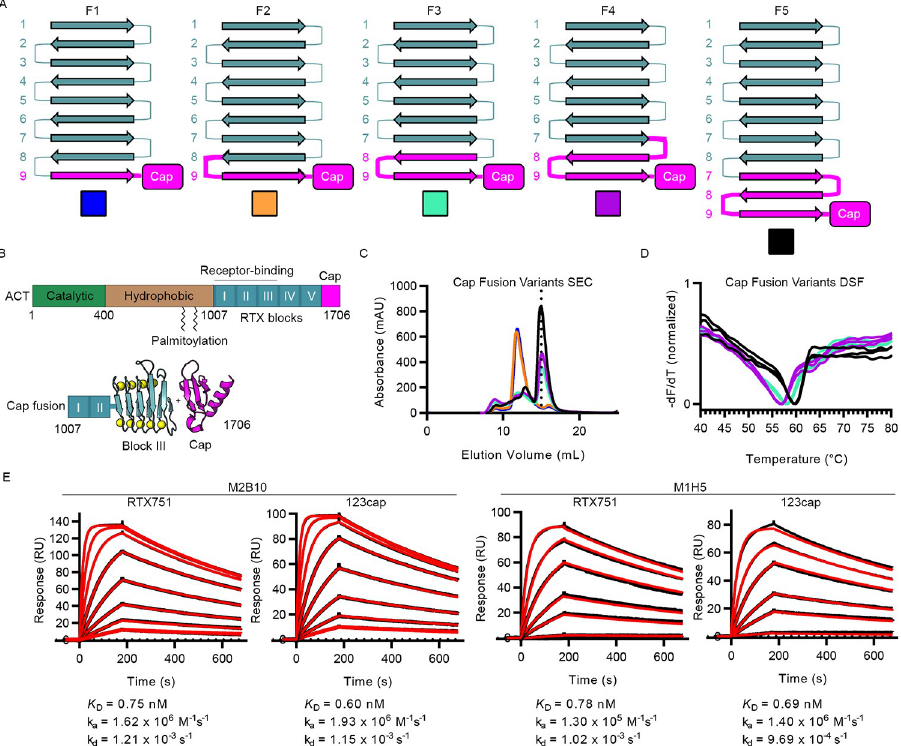
Fig 1. Design and characterization of cap-stabilized RTX domain fragments containing blocks I–III. (A) Design scheme of fusions between block III and block V cap fragment. RTX repeats from block III and V are represented in terms of their β -strands, numbered by RTX repeat within each RTX block, and their connecting segments, which are mostly Ca 2+ -binding turns but can contain loop insertions. For each variant, the strands and connecting segments from block III are shown in teal, and those from block V are shown in magenta. (B) Schematic of the ACT gene showing the catalytic domain (green), hydrophobic segment (brown), palmitoylation sites, RTX domain with RTX blocks (teal) and C-terminal cap (magenta). The scheme is shown for fusing the C-terminal cap to a fragment containing RTX blocks I-III, with block III and the C-terminal cap shown in 3D cartoon representation. (C) Size- exclusion chromatography elution profiles for purified cap fusion variants, with colors corresponding to the boxes in A. The dotted line represents the peak elution volume that is consistent with monomeric 123cap. (D) Differential scanning fluorimetry melting profiles for F3, F4, and F5, with data shown as the negative first derivative of the fluorescence intensity. Colors correspond to the boxes in A. (E) Surface plasmon resonance kinetic measurements of M2B10 and M1H5 Fab binding to RTX751 and 123cap. Measured signal for each Fab concentration is shown as a black line, and kinetic fits are shown as red lines. Fit kinetic parameters and equilibrium dissociation constants are shown for each interaction under the corresponding concentration